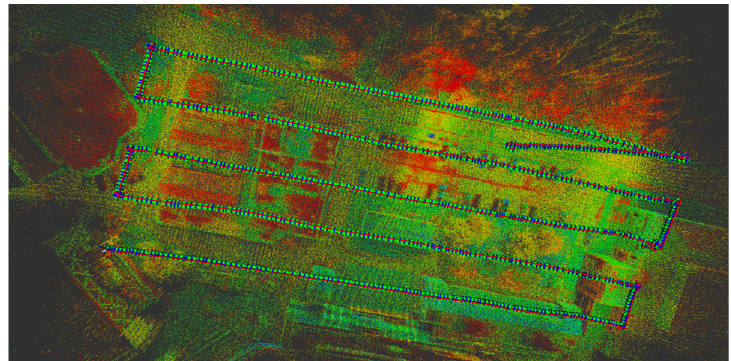
Figure 8. False-color combination of the multispectral orthomosaic for the first test site.